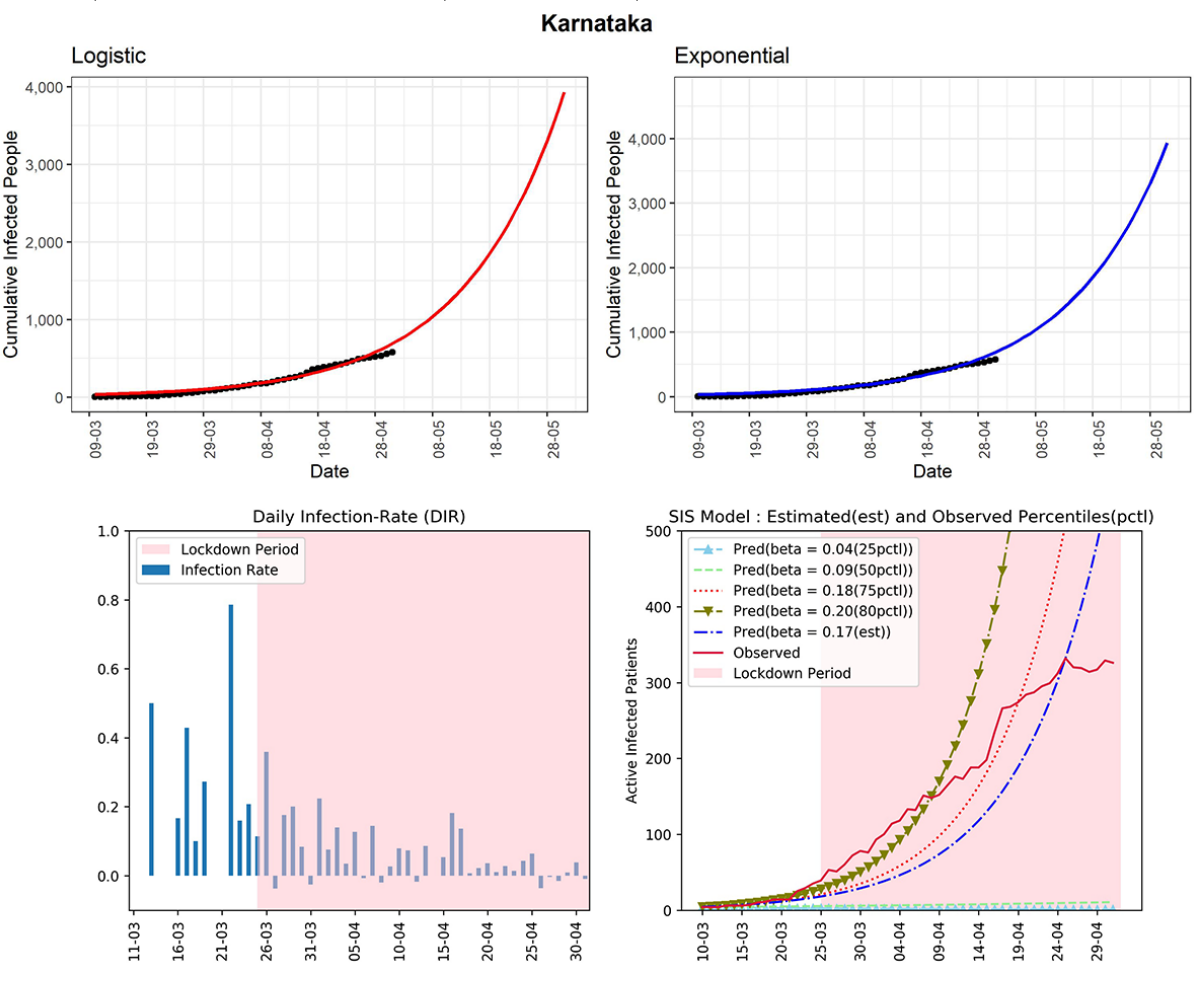
Figure 14. Graphs for the state of Karnataka. SIS: